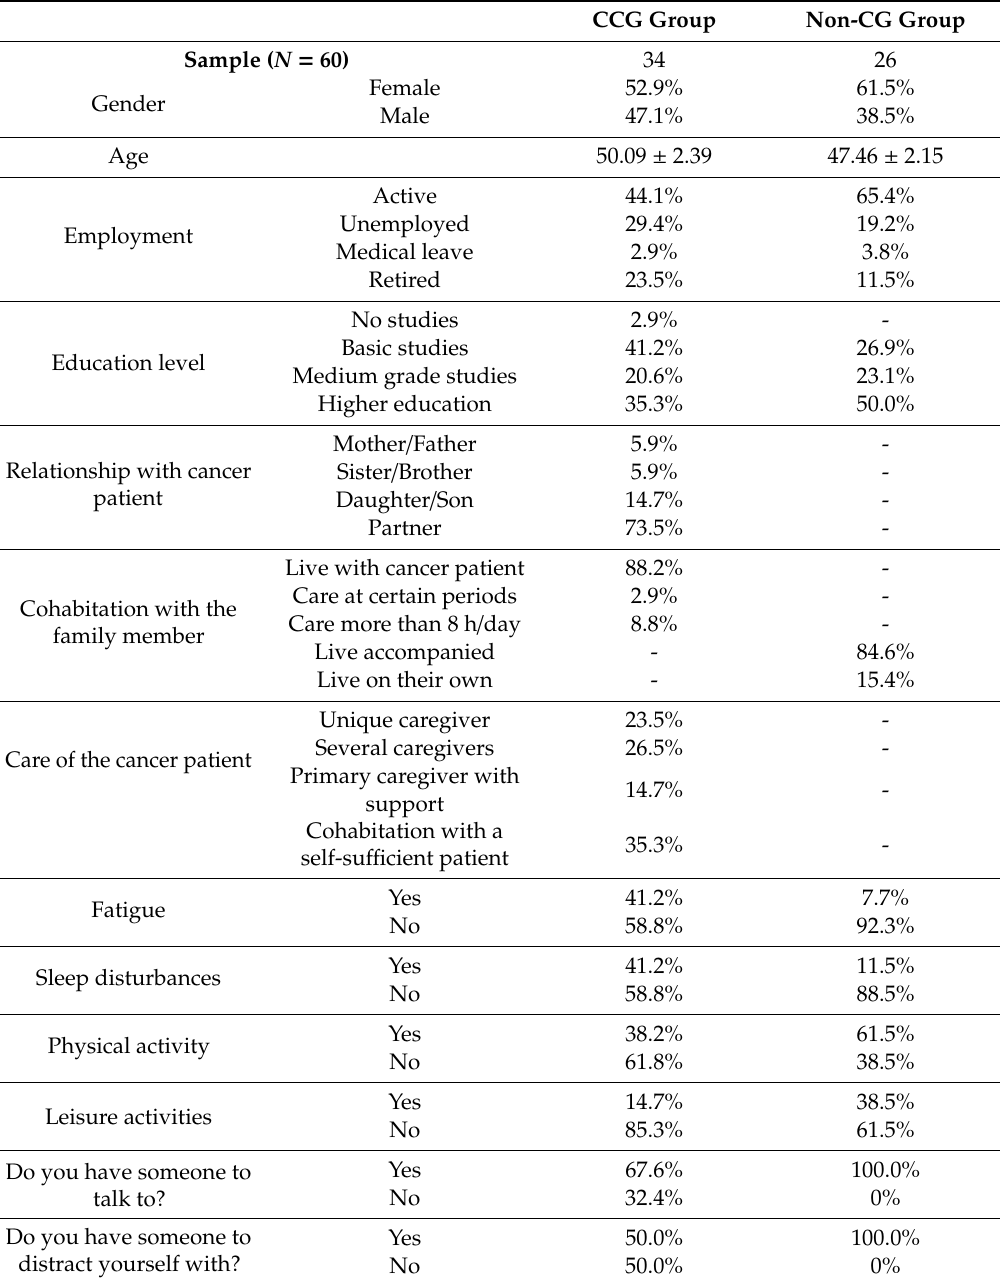
Table 1. Characteristics of caregivers and